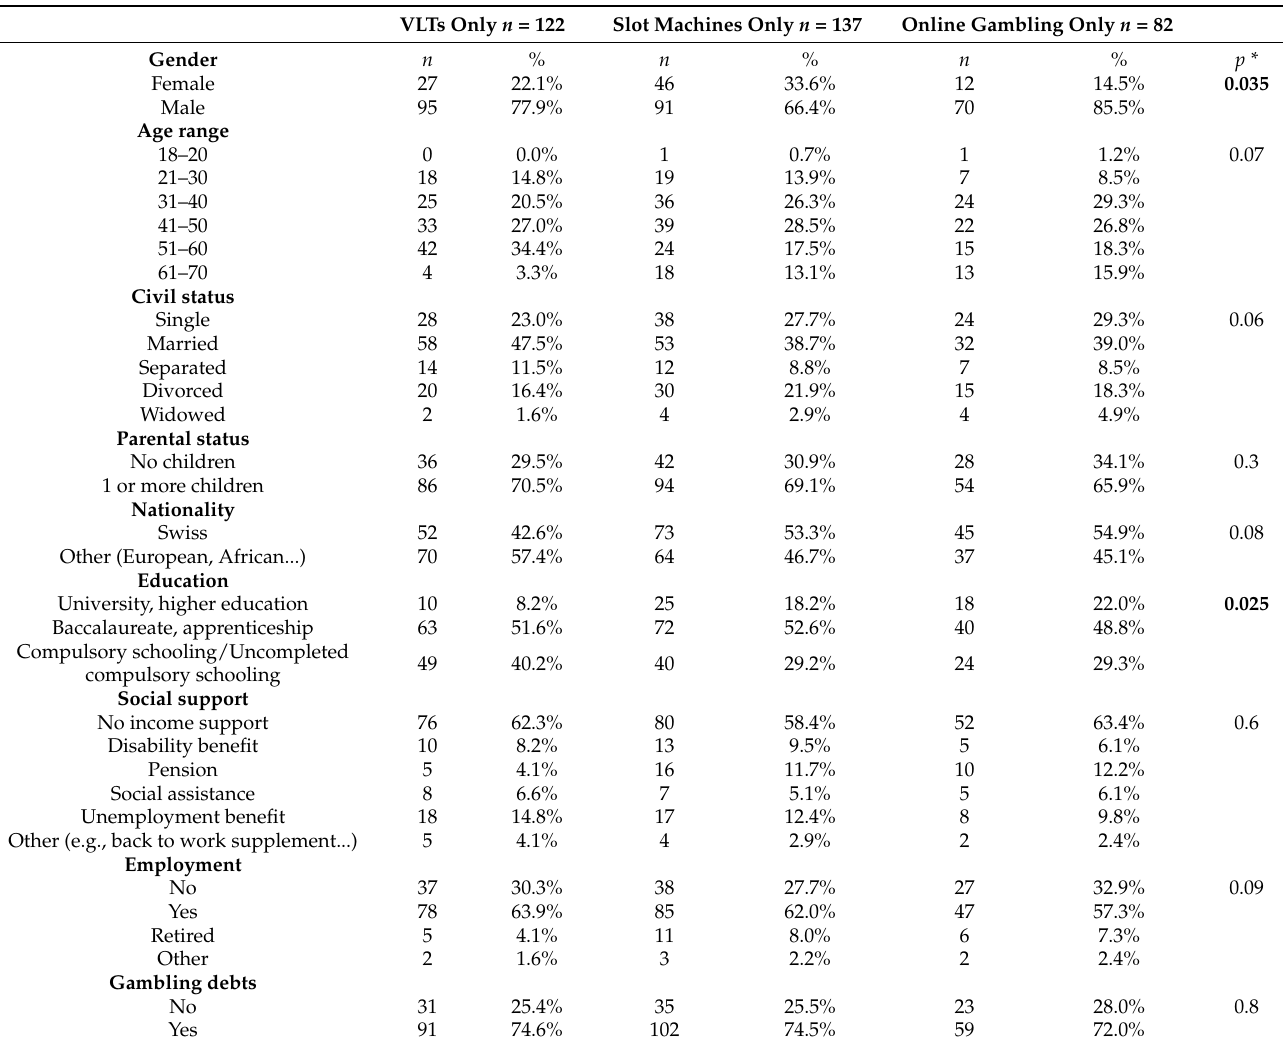
Table 1. Sociodemographic characteristics of new referrals by